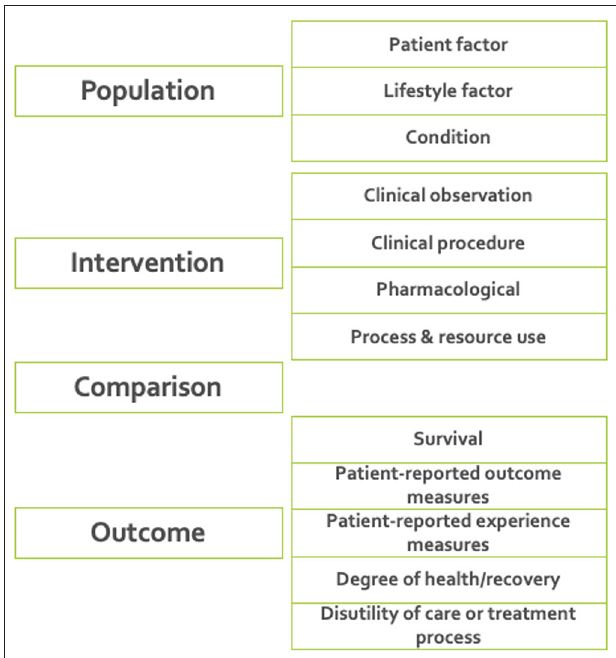
FIGURE 2 | The final taxonomy was organized in two levels, with the first being based on the PICO-model for evidence-based decisions ( 38). The taxonomy was implemented as a tool for support of further developments including standard-sets for new